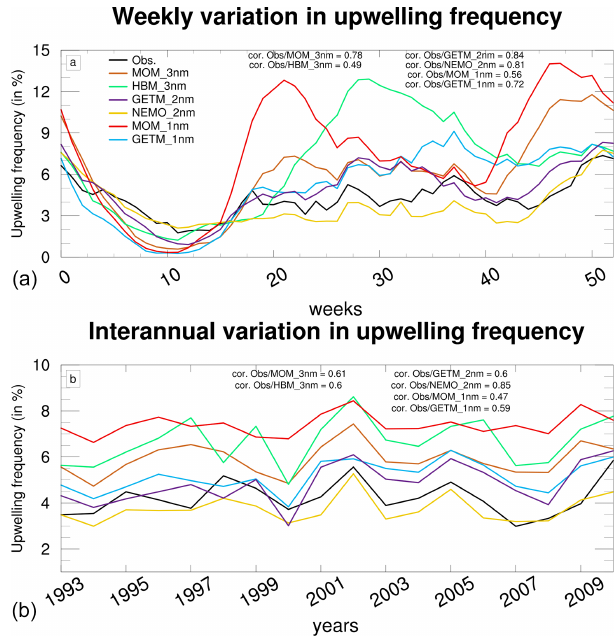
Figure 13. Weekly (a) and interannual (b) variations in upwelling frequencies (in %) according to observations (black lines) and the models MOM_1nm, MOM_3nm, HBM_3nm, GETM_1nm, GETM_2nm, and NEMO_2nm (red, green, blue, and yellow lines, respectively). The correlations between observations and models are shown in the top-right corners.